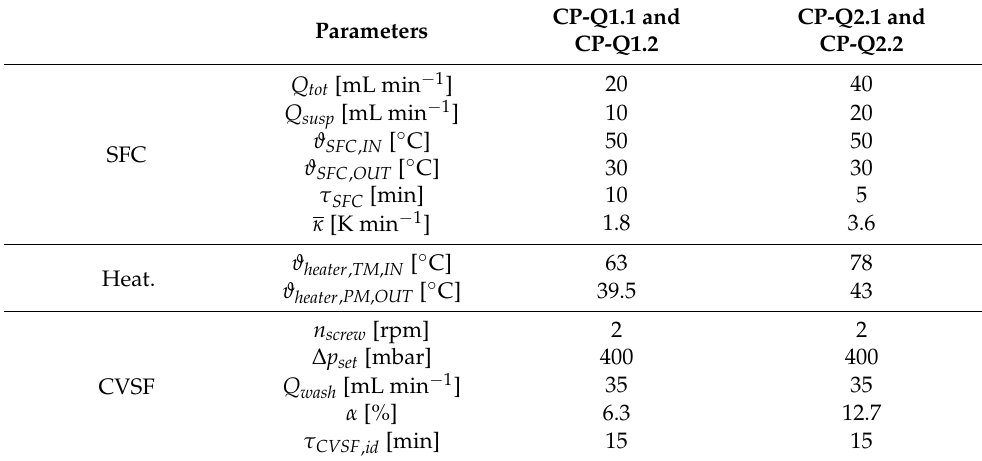
Table 1. Operating and resulting parameters for continuous crystallization inside the SFC, for the heater and for the particle isolation inside the CVSF in a two-fold determination of each operat- ing